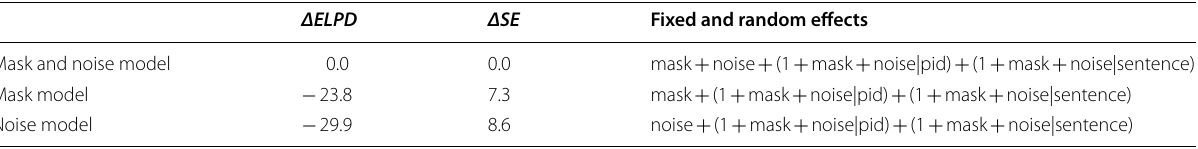
Table 3 Change in LOO information criterion relative to the best fitting model without an interaction term for the sentence intelligibility analysis with older